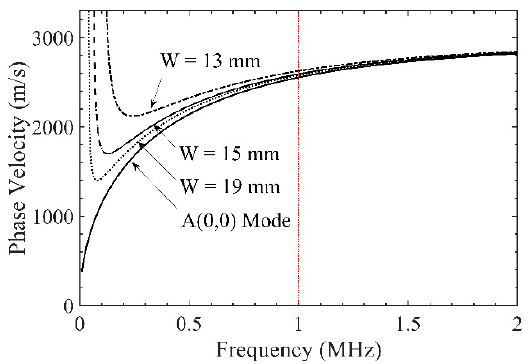
Figure 17. Phase velocity dispersion curves of the A(0,2) mode in a 1.5 mm thick SS304 plate with variation of the plate width.